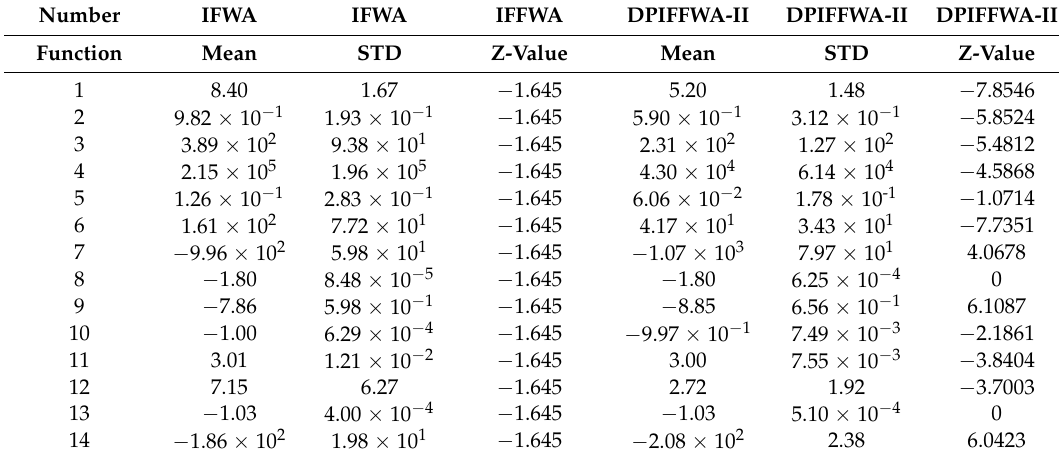
Table 14. Hypothesis test between IFWA and DPIFFWA-II with SI = 2.